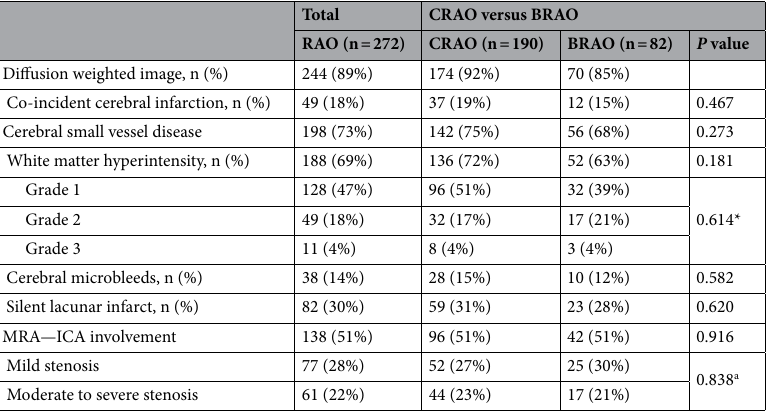
Table 2. Comparison of brain MRI findings between patients with central retinal artery occlusion (CRAO) and patients with branch retinal artery occlusion (BRAO). Data are presented as number (%). P < 0.05 was deemed to indicate clinical significance, values in boldface are statistically significant. MRI = magnetic resonance imaging, MRA = magnetic resonance angiography, ICA = internal carotid artery. a Linear-by-linear